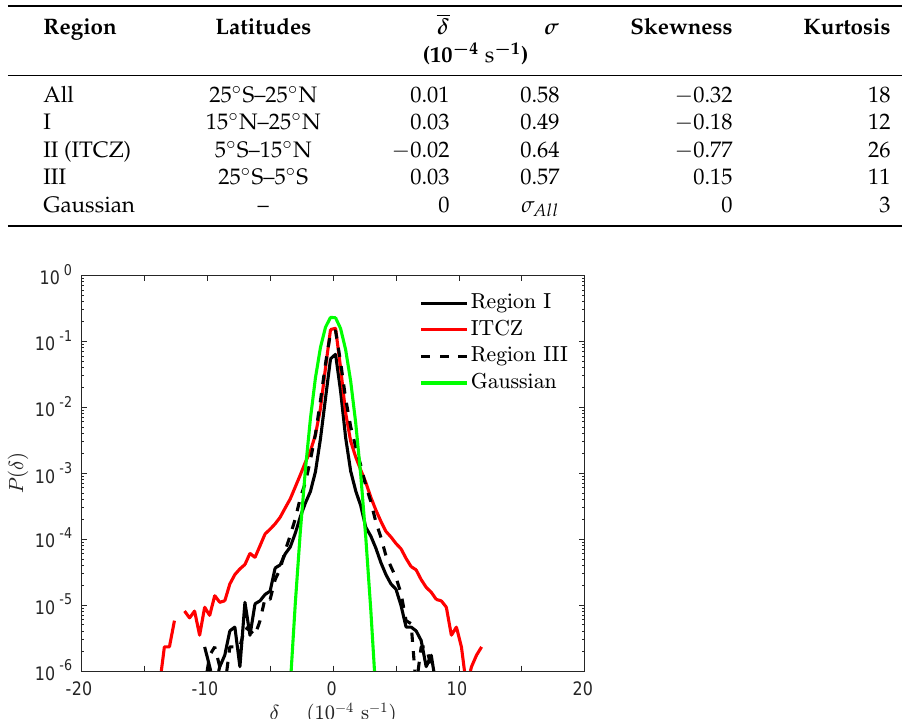
Figure 6. PDFs of wind divergence for Regions I, ITCZ, and III (December 2012). Green curve is a Gaussian distribution with zero mean and standard deviation for all data ( σ All